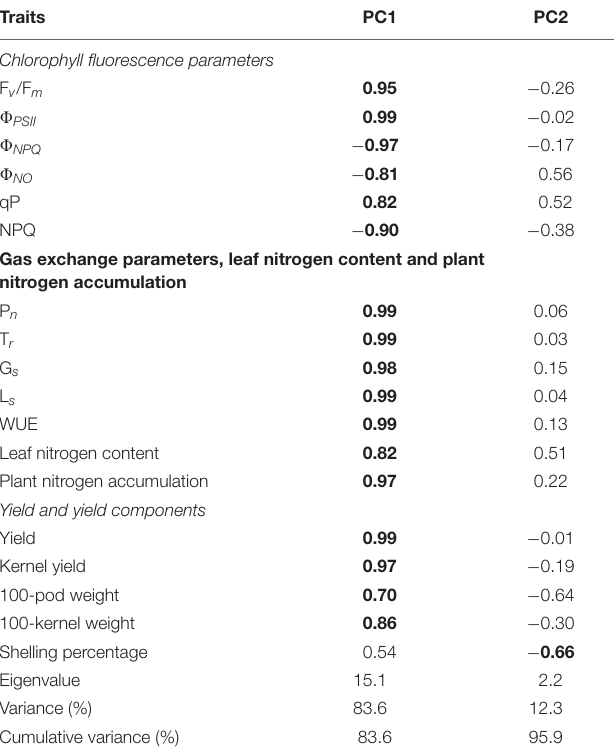
TABLE 5 | Variable loading scores of 18 parameters for four biochar application rate and the proportion of variation of each principal component. Traits PC1 PC2 Chlorophyll fluorescence parameters